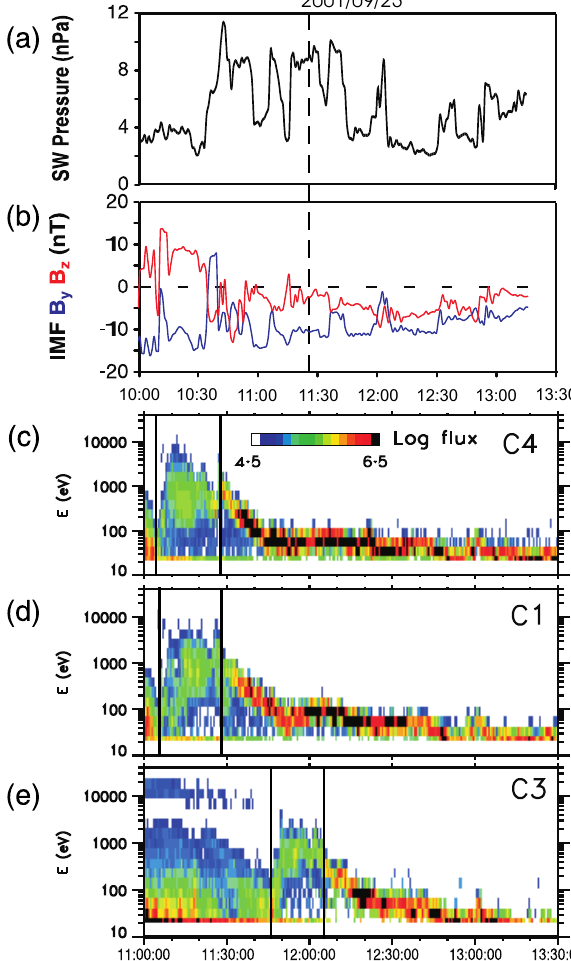
Fig. 2. Overview of an upflowing ion event on 23 September 2001. From top to bottom, (a) time evolution of the solar wind dynamic pressure; (b) time evolution of the IMF B y (blue) and B z (red) com- ponents; and (c) , (d) , (e) , omnidirectional O + flux measurements in Log[m − 2 s − 1 sr − 1 keV − 1 ] aboard C4, C1 and C3, respectively. The dashed vertical line in Fig. 2a indicates the onset of O + obser- vations with